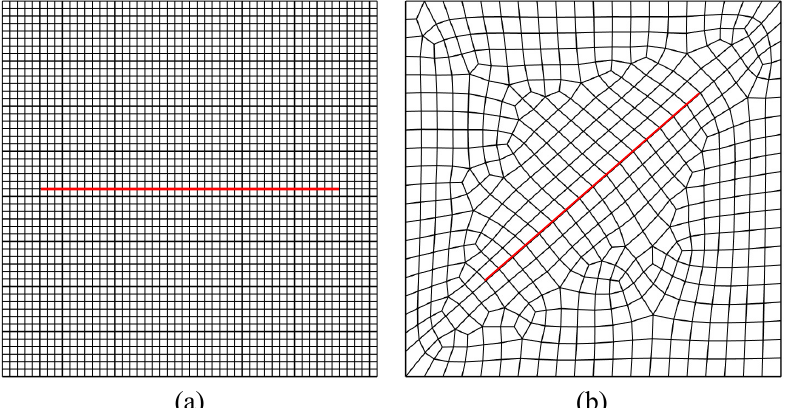
Figure 5. Mesh distribution of the square plate: ( a ) horizontal crack; ( b ) inclined